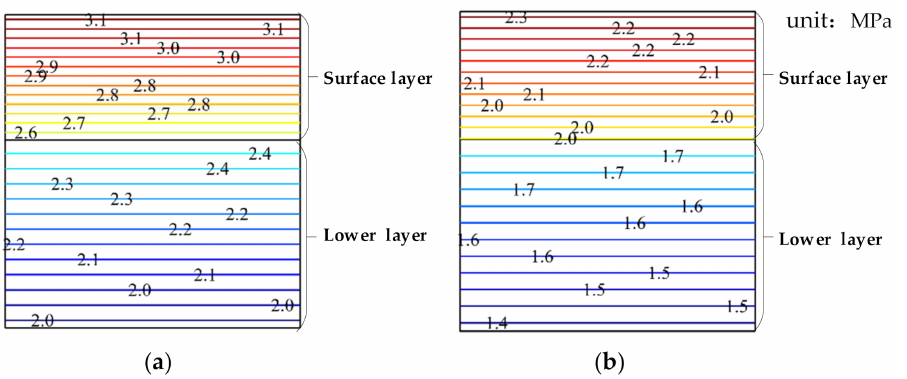
Figure 7. Cloud chart of the shear stress as a function of the pavement depth, where ( a ) is the case of the water phase transition and ( b ) is the case of the nonwater phase